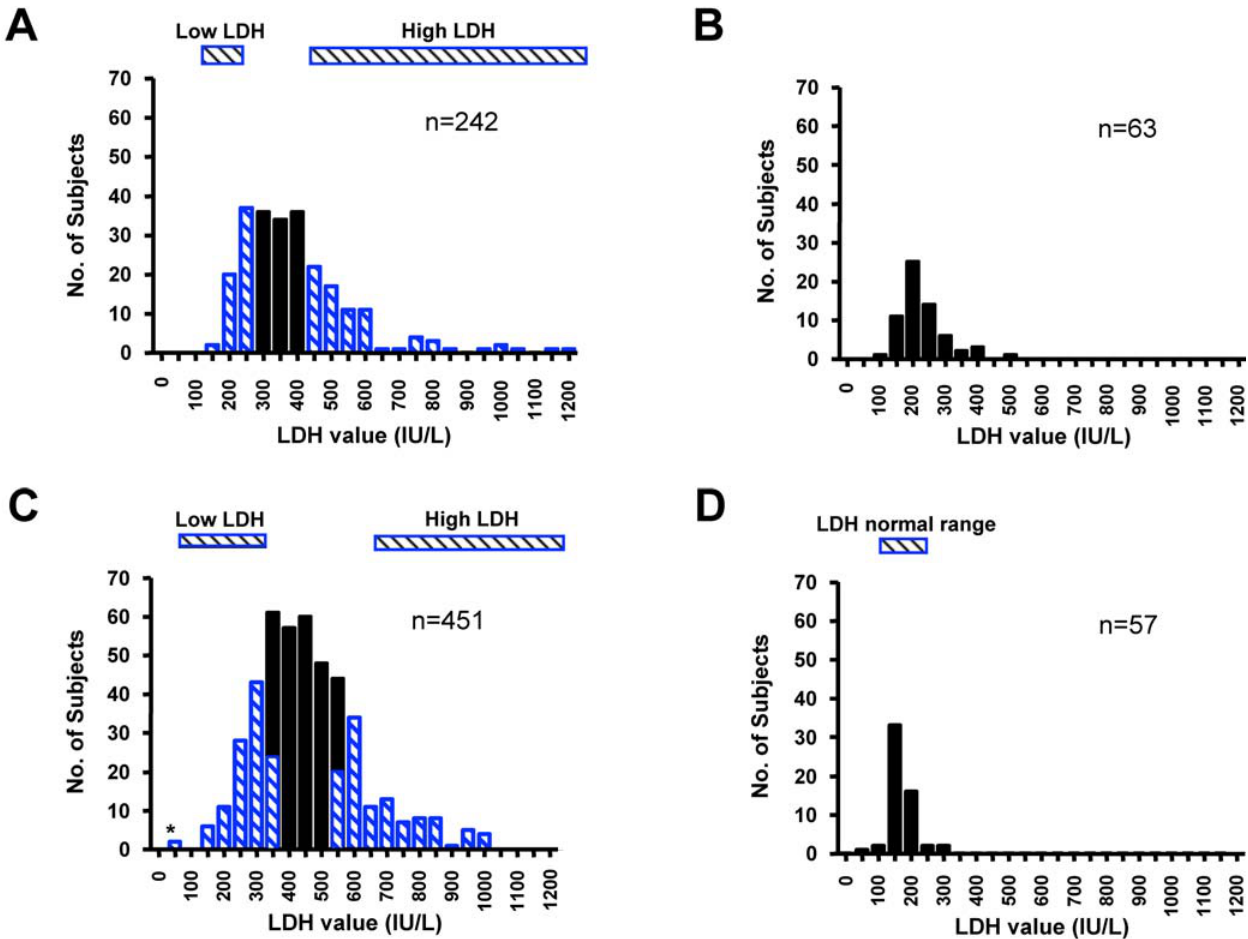
Figure 2. LDH distributions in sickle cell anemia. Panel A: LDH distribution at NIH. Blue bars indicate either the Low LDH study group defined by LDH below 278.0 IU/L or the high LDH group (LDH above 451.0 IU/L). Panel B: LDH distribution among NIH subjects with Hemoglobin SC disease and sickle b + thalassemia. Panel C: Distribution of median LDH values from up to three LDH measurements in the CSSCD. The blue bars show the Low LDH (at or below the LDH 25th percentile of 340.5 IU/L) and the High LDH (at or above the 75th percentile of 546.0 IU/L) study groups, respectively. * Two were excluded from the Low LDH group for unexpectedly low LDH values. Panel D: LDH distribution among healthy controls.